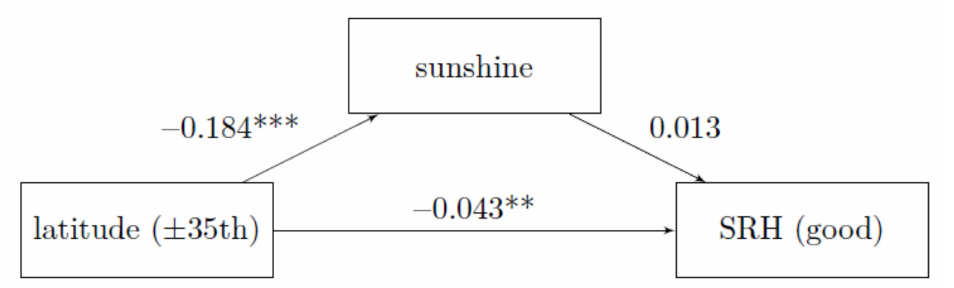
Figure 4. Mediation with control variables, Reference: ISSP 2011, average marginal effects, own